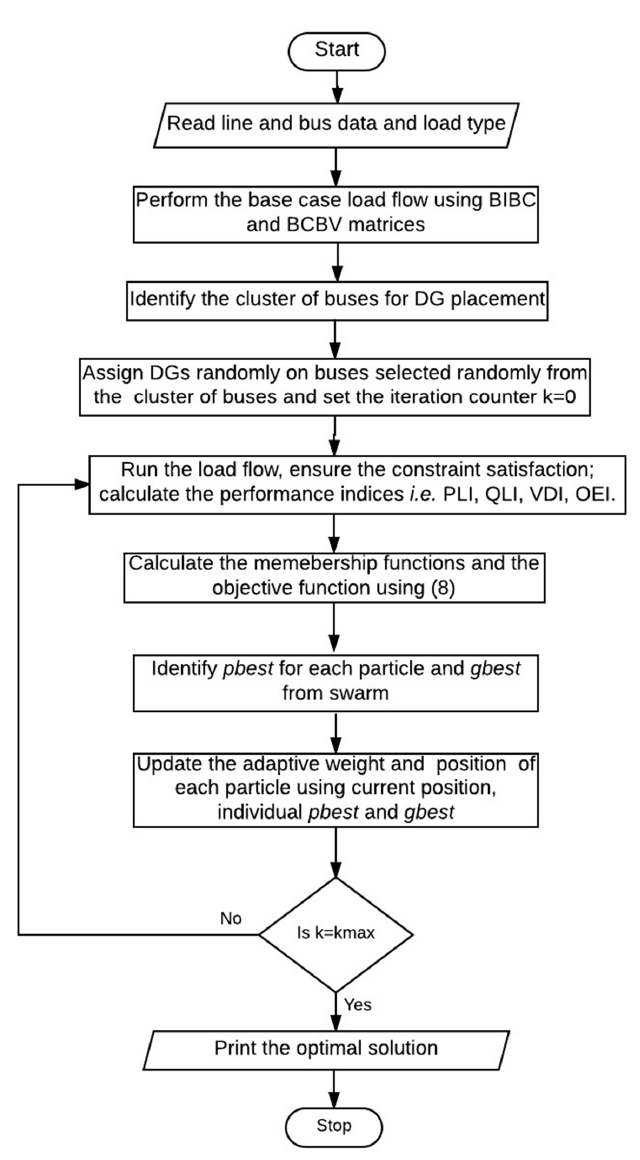
Figure 1. Flowchart for the proposed DG allocation technique.